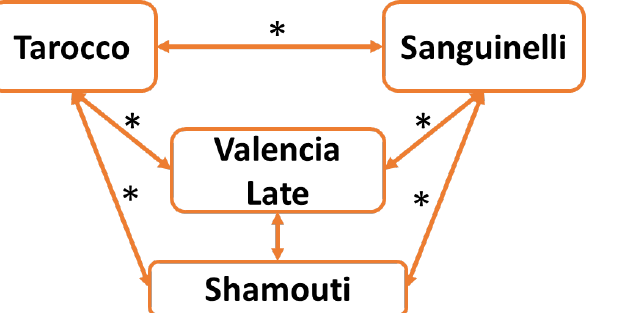
Figure 5. Results of triangle tests conducted on essential oils from the peels of four orange cultivars. The stars above the arrows between two cultivars indicate that a significant difference was observed based on the triangle test ( p ≤ 0.05).